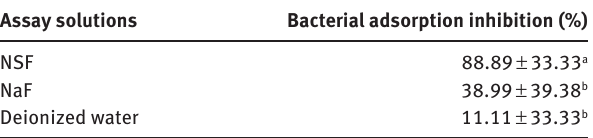
Table 5: Percentage (mean ± standard deviation) of adsorption inhibition of Streptococcus mutans AU159 to enamel surface treated with the test and control